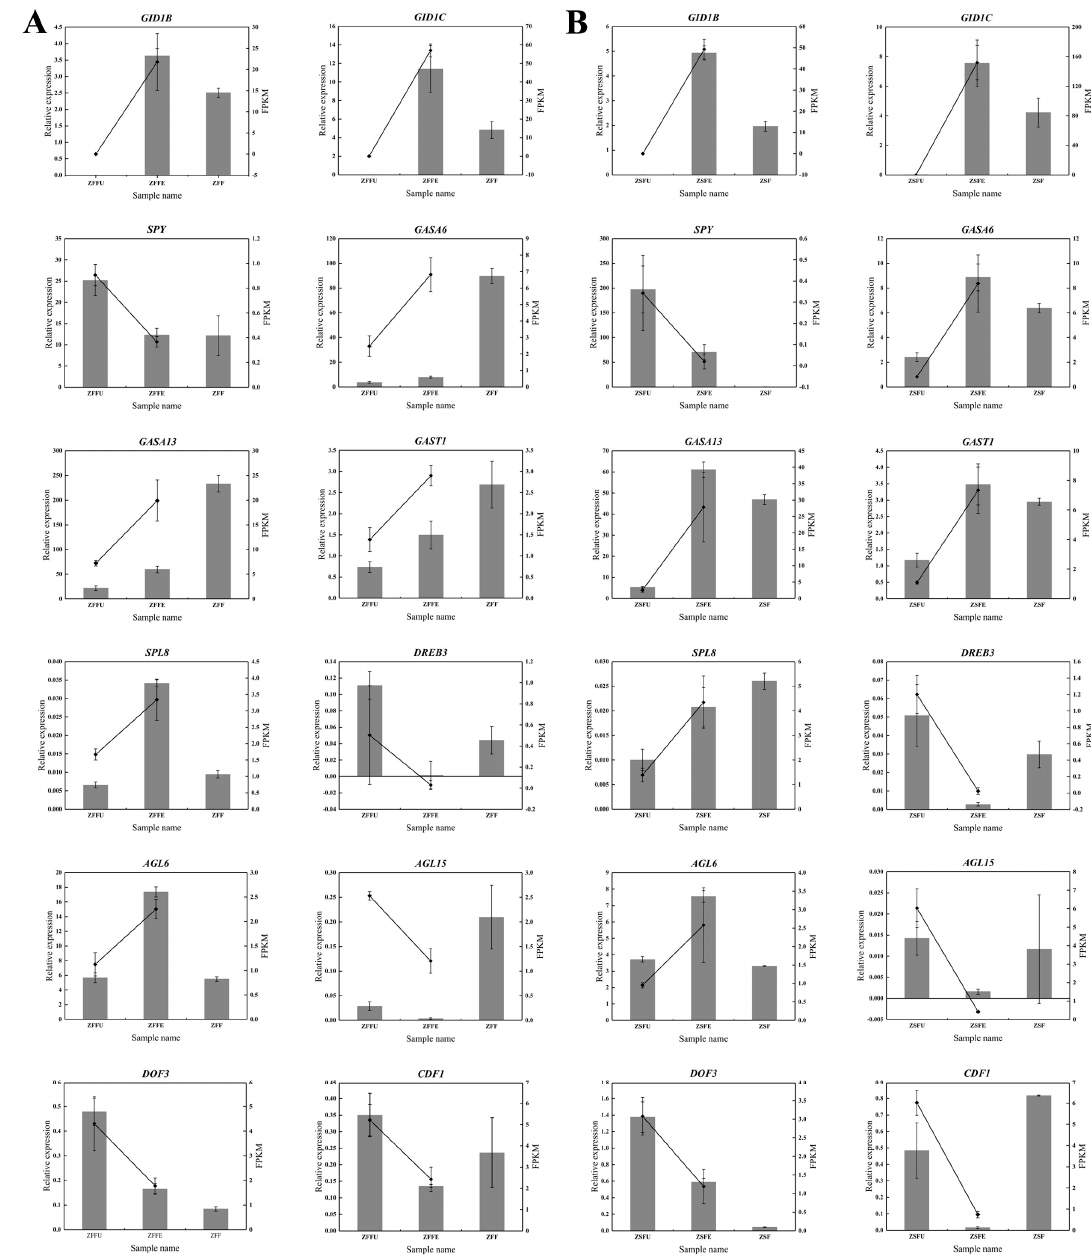
Figure 5. qRT-PCR analysis of 12 DEGs. ( A ) The line charts and histograms of qRT-PCR and transcriptome expression of 12 DEGs in spring flowering initiation; ( B ) the line charts and histograms of qRT-PCR and transcriptome expression of 12 DEGs in summer flowering initiation. Using qRT-PCR technology, we examined the relative expression levels of 12 DEGs in spring and summer dormant and expanded flower buds to verify the accuracy of transcriptome sequencing. Meanwhile, we also examined the relative expression levels of these genes in spring and summer red-tepal-exposed flower buds to exhibit their expression changes during spring and summer flowering. The line charts and histograms represent the expression level of 12 DEGs in transcriptome sequencing and qRT-PCR analysis, respectively. The left y-axis represents the relative expression from the qRT-PCR results, while the right y-axis represents the FPKM value from the RNA-Seq. ZFFU = spring dormant flower buds; ZFFE = spring expanded flower buds; ZFF = flower buds that red tepals were exposed in spring; ZSFU = summer dormant flower buds; ZSFE = summer expanded flower buds; ZSF = flower buds that red tepals were exposed in summer.